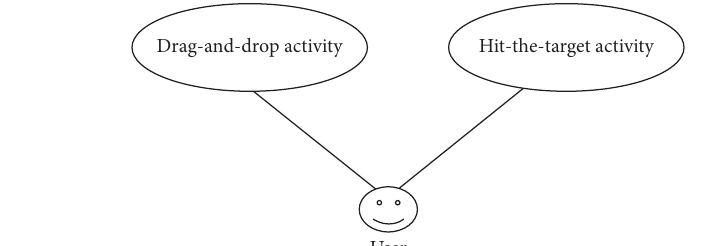
Figure 2: User case study.